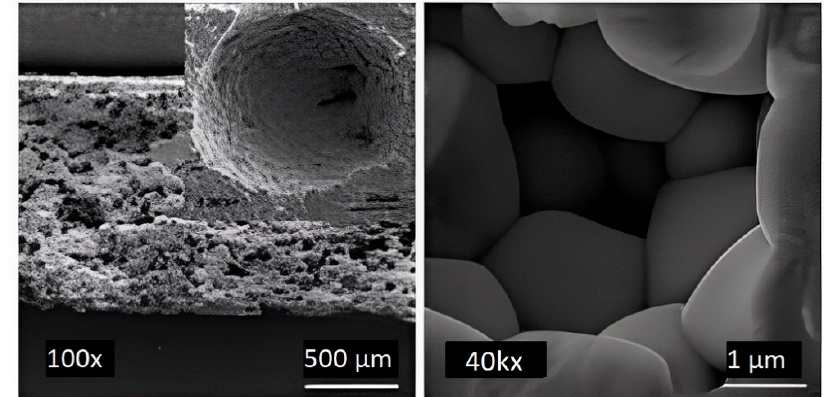
Figure 16. SEM images of produced porous PZT-PCN ceramic synthesized by 5 wt.% of PMMA as PFA (Reprinted from Ref. [92], copyright (2019), with the kind permission of Elsevier Ltd.).